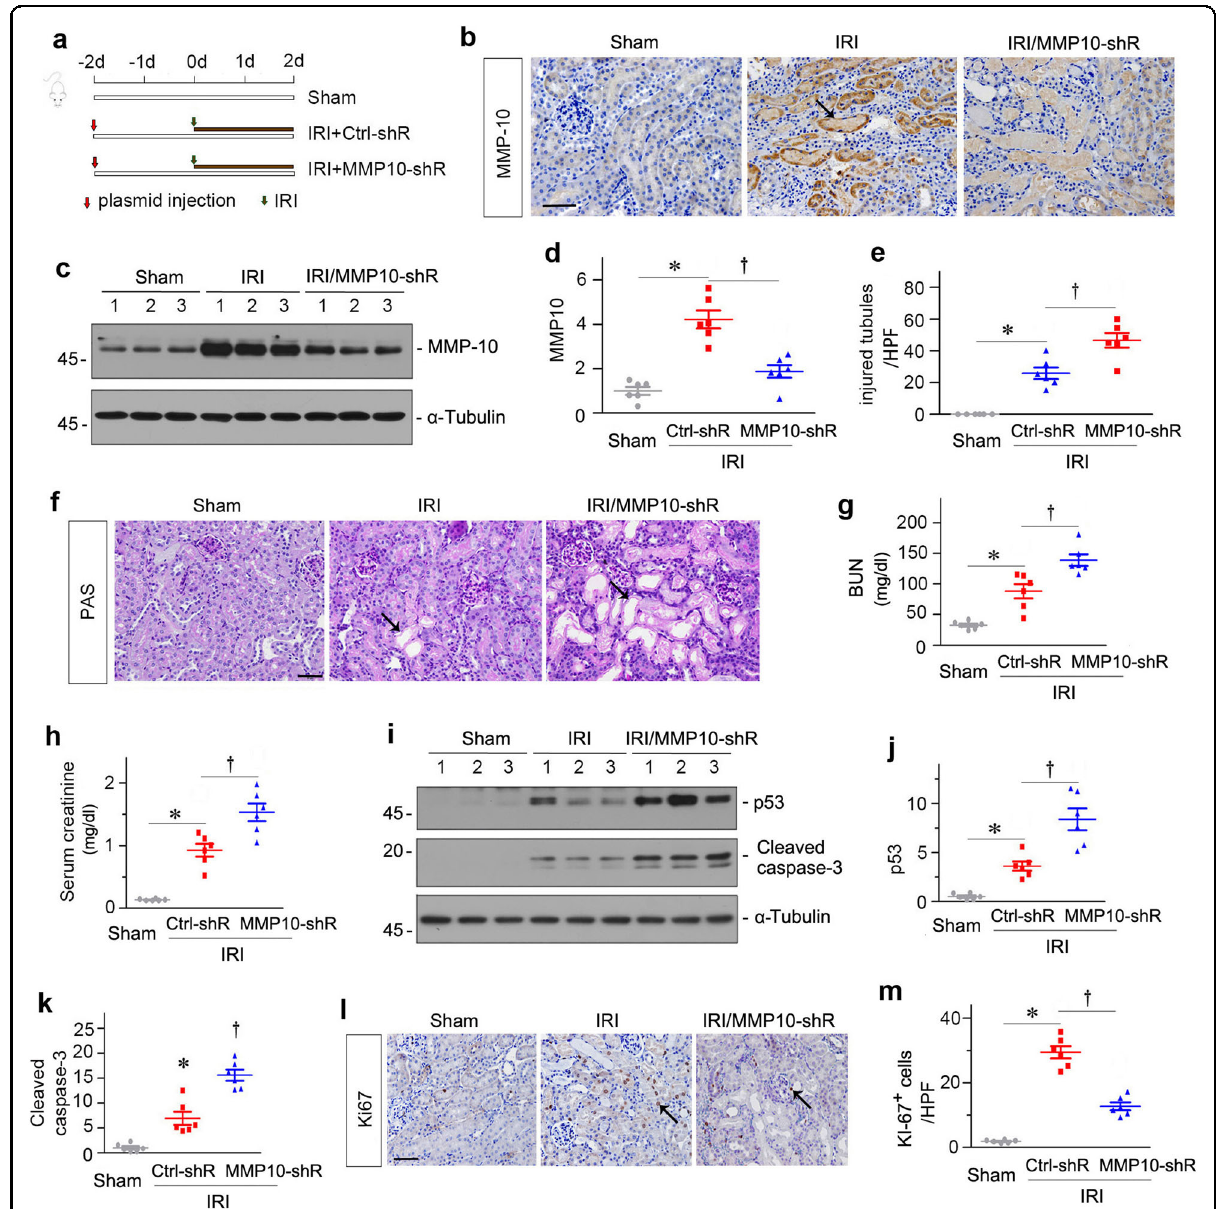
Fig. 4 Knockdown of MMP-10 aggravates kidney injury after IRI. a Experimental design. Red arrows indicate the injection of Ctrl-shR and MMP-10- shR plasmids. Green arrows indicate the timing of IRI surgery. b Representative micrographs show renal MMP-10 expression in different groups as indicated. Arrow indicates positive staining of MMP-10 expression protein. Scale bar, 50µm. c Representative western blots show renal MMP-10 protein expression in different groups as indicated. d Graphic presentation shows the relative MMP-10 protein levels in different groups. * P <0.05 versus sham controls ( n = 6); † P <0.05 versus IRI injected with Ctrl-shR ( n = 6). e Representative micrographs show kidney morphology in different groups of mice as indicated. Kidney sections were subjected to PAS staining. Arrows indicate injured tubules. Scale bar, 50µm. f Quantitative analyses of injured tubules in three groups. At least 10 randomly selected high-power fi elds (HPF) were evaluated and results were averaged for each kidney. * P <0.05 versus sham controls ( n = 6); † P <0.05 versus IRI injected with Ctrl-shR ( n = 6). g , h Graphic presentations show blood urea nitrogen (BUN) ( g ) and serum creatinine ( h ) levels in different groups as indicated. * P <0.05 versus sham controls ( n = 6); † P <0.05 versus IRI injected with Ctrl-shR ( n = 6). i Representative western blots show renal expression of p53 and cleaved caspase-3 in different groups as indicated. Numbers (1, 2, and 3) indicate each individual animal in a given group. j , k Graphic presentations show the relative abundance of renal p53 ( j ) and cleaved caspase-3 ( k ) proteins in different groups. * P <0.05 versus sham controls ( n = 6); † P <0.05 versus IRI injected with Ctrl-shR ( n = 6). l Representative micrographs show Ki-67 protein expression in different groups as indicated. Kidney sections were immunostained with speci fi c antibody against Ki-67. Arrows indicate positive staining. Scale bar, 50µm. m Quantitative determination of Ki-67 + cells is presented. At least 10 randomly selected high-power fi elds (HPF) were evaluated and results were averaged for each kidney. * P <0.05 versus sham controls ( n = 6); † P <0.05 versus IRI injected with Ctrl-shR ( n =